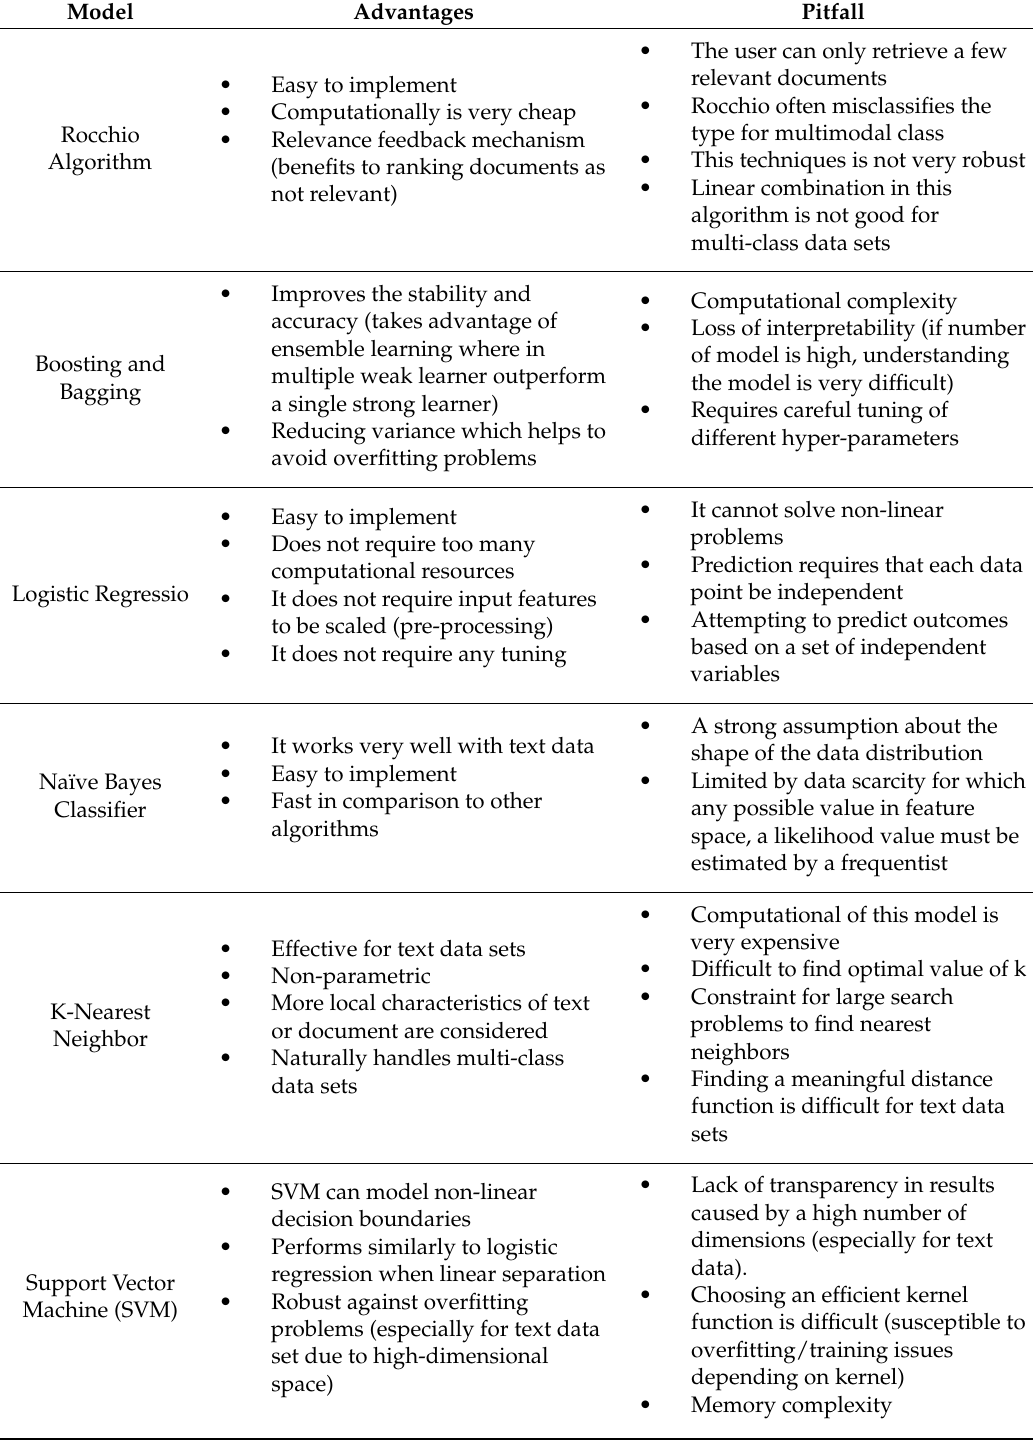
Table 2. Text classification comparison (Rocchio algorithm, boosting, bagging, logistic regressio, Naïve Bayes classifier, k-nearest Neighbor, and Support Vector